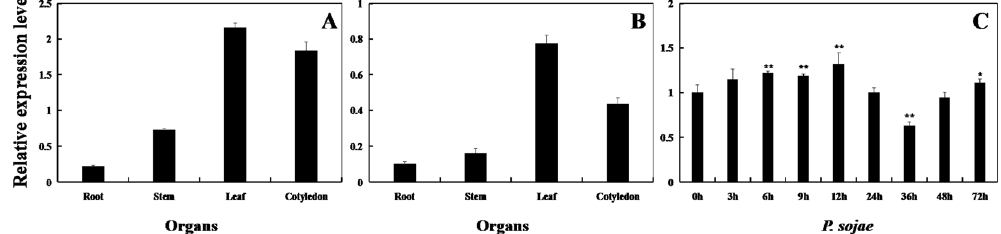
Figure 2. Expression patterns of GmPAL2 . 1 in ‘Dongnong 50 ′ soybean plants. ( A ) The transcript abundance of GmPAL2 . 1 in various tissues of ‘Suinong 10’ soybean under normal condition. ( B ) The transcript abundance of GmPAL2 . 1 in various tissues of ‘Dongnong 50’ soybean under normal conditions. ( C ) The transcript levels of GmPAL2 . 1 in ‘Dongnong 50’ soybean under P . sojae treatment. The roots, stems, leaves and cotyledons were prepared from 14-day-old seedlings. The relative transcript levels of GmPAL2 . 1 were quantified compared with mock plants at the same time points. The amplification of the soybean Actin ( GmActin4 ) gene was used as an internal control to normalize the data. For each sample, three biological replicates were analyzed with their respective three technical replicates. Bars indicate the standard error of the